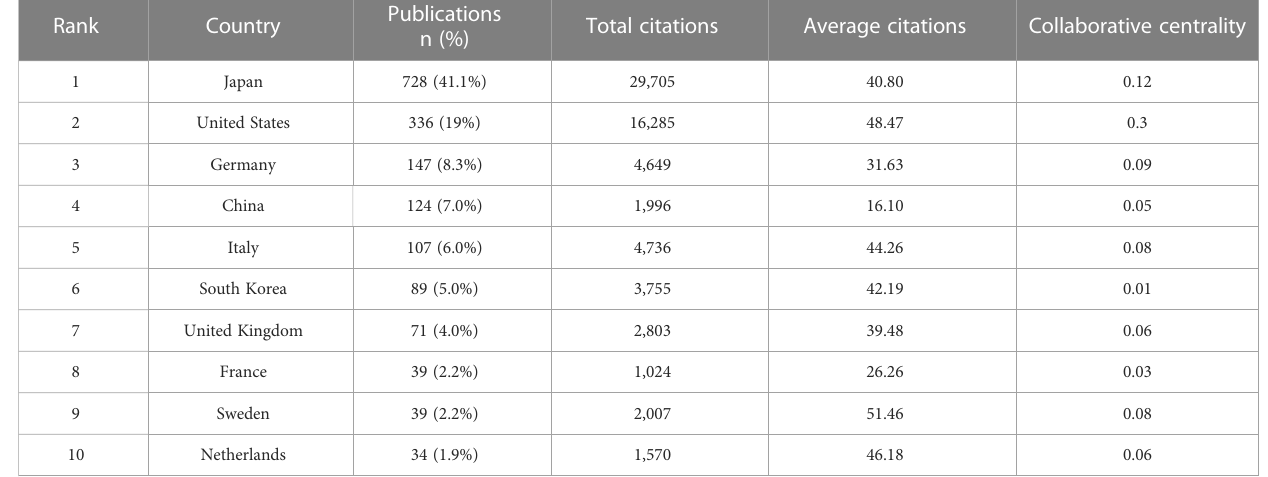
TABLE 1 The top 10 most productive countries in terms of AIP research.